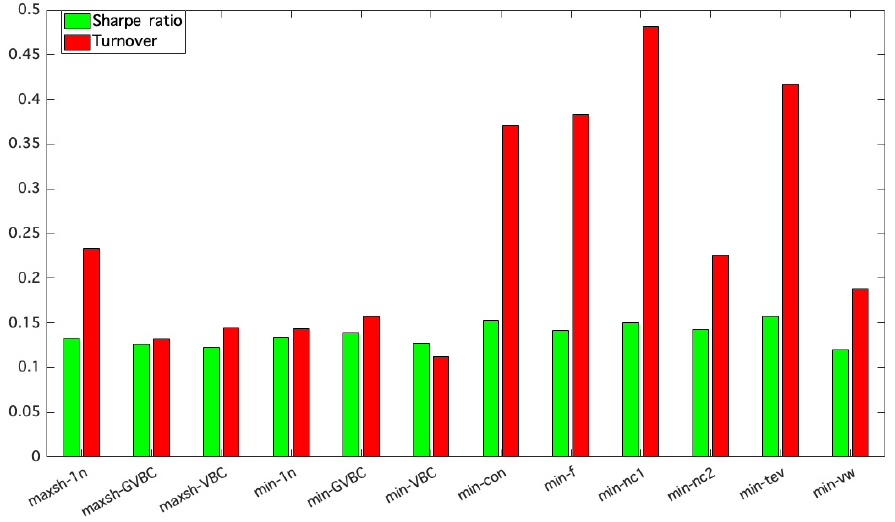
Figure 4. Comparison among constrained optimization models.